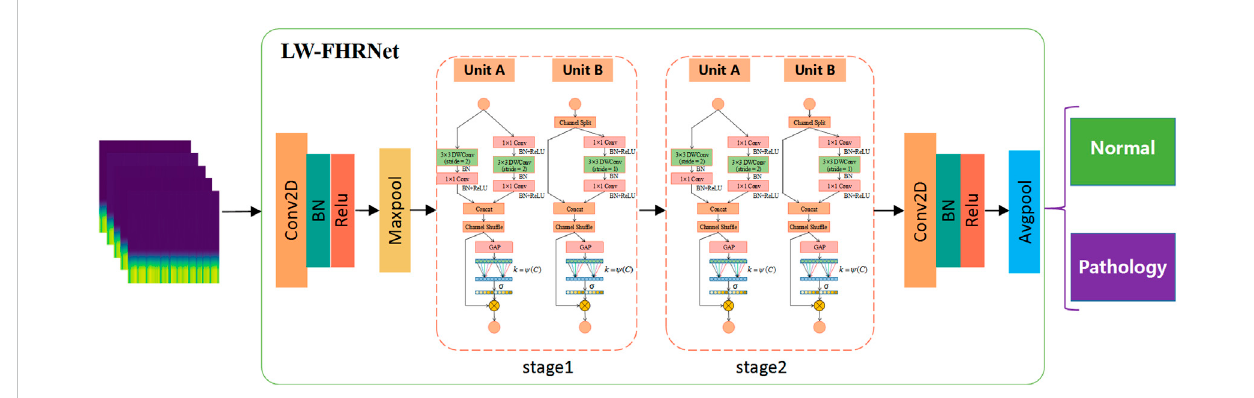
FIGURE 4 The structure of LW-FHRNet. Notes: Conv2D: Convolution2D; BN: Batch Normalization; Maxpool: Max pooling; Avgpool: Average